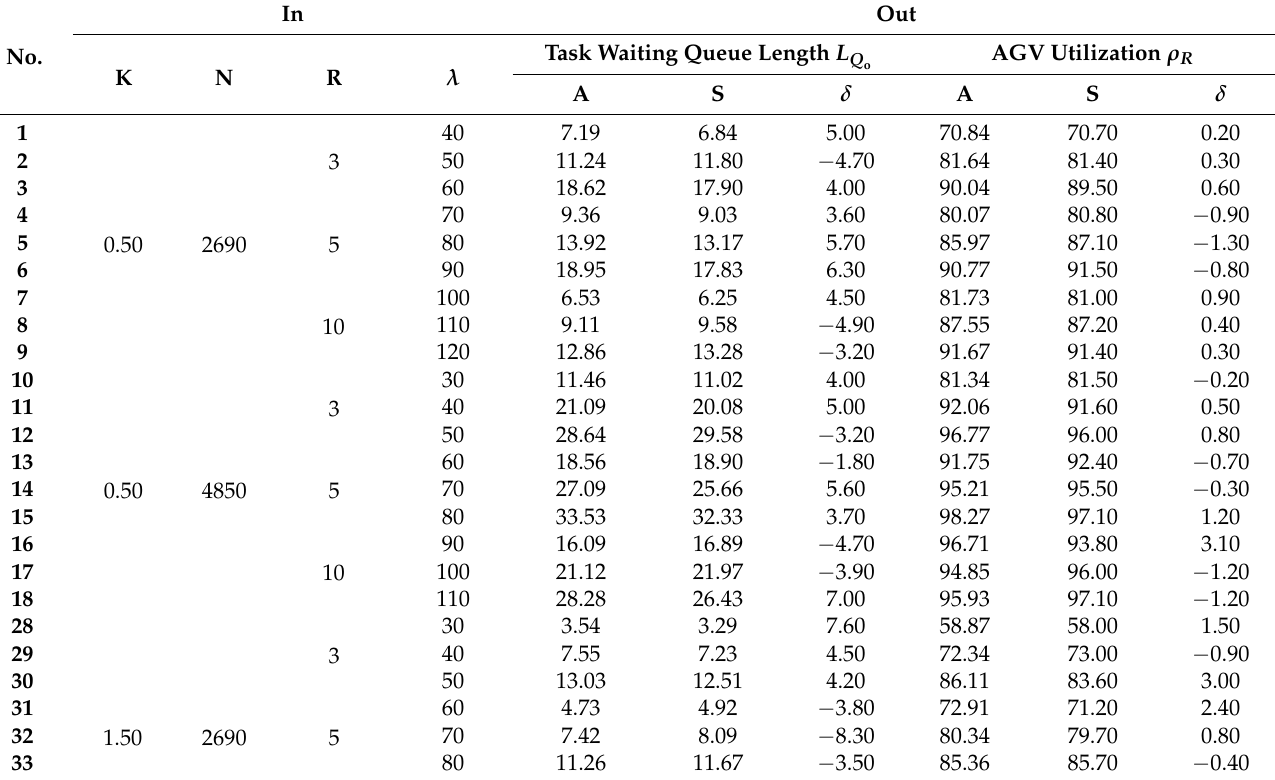
Table 3. Comparison between simulation and theoretical